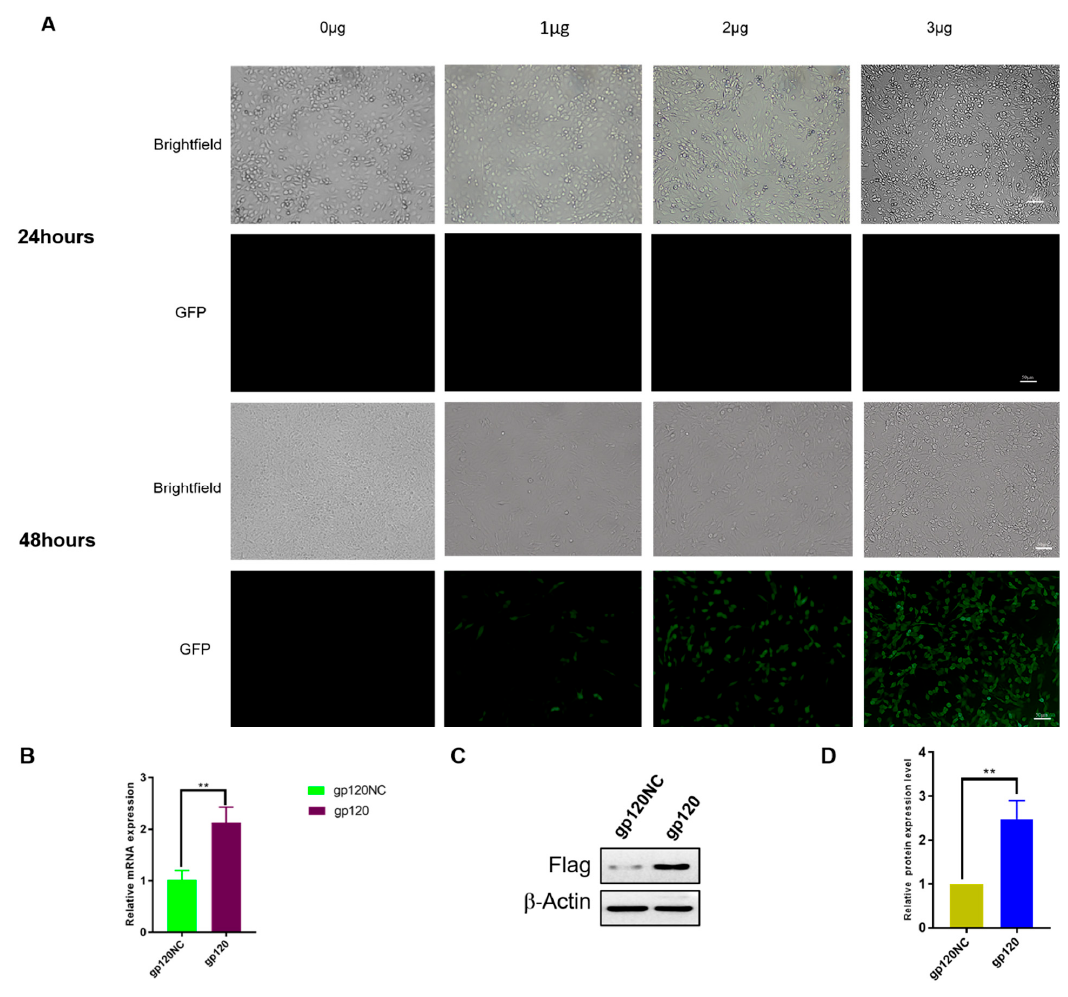
Figure 1. ( A ) Fluorescence microscope images of the PC12 cells displaying Green Fluorescence Plas- mid (GFP)-gp120 protein. After 48 h, the PC12 cells were exposed to various doses (1 µ g, 2 µ g, 3 µ g) of the gp120 protein coupled with the matching empty vector as a gp120 negative control (gp120NC). GFP was expressed more strongly in PC12 cells transfected with the 3 µ g concentration of gp120 than with the other concentrations. ( B ) After immunofluorescence, the expression of 3 µ g gp120, which was transfected in the PC12 cell line, the same batch of samples were harvested extracted for mRNA and revealed significant expression by qPCR in comparison to the gp120 negative control (gp120NC). ( C ) Again, samples with similar conditions were lysed for Western blotting in order to measure the expressed protein levels between the control group and the treatment group. ( D ) the treatment group showed significantly increased gp120 protein expression than the control group, gp120NC = glycoprotein 120 Negative control, with p = 0.0038. B-actin was used as loading control. ** p < 0.01, t -test, n =